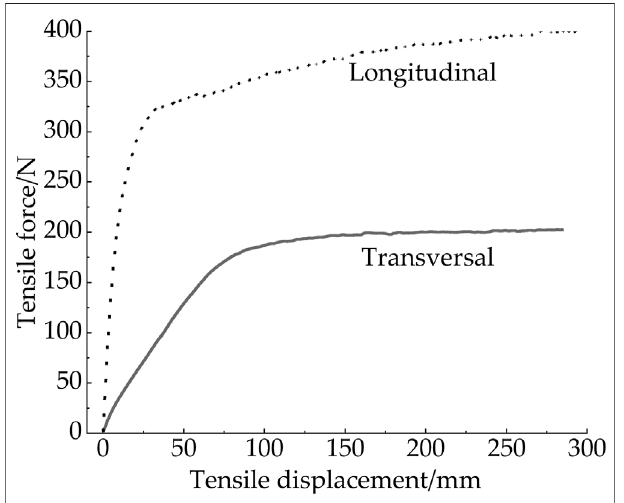
FIGURE 5 | Force curve of HDPE GN2 in two